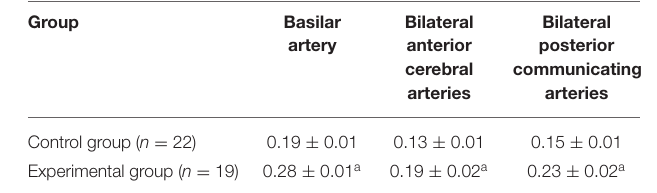
Extended Average Group Basilar angle ( ◦ ) length (mm) elongation rate (%)